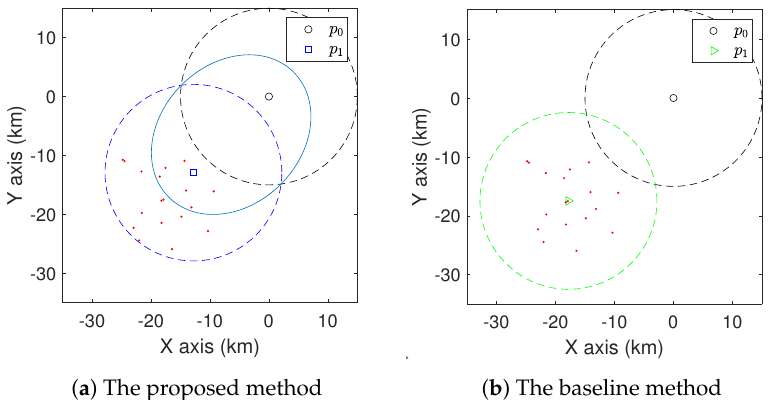
Figure 5. Comparison of the proposed method and baseline method in the first simple case with one charging station. The sites are represented by red dots.